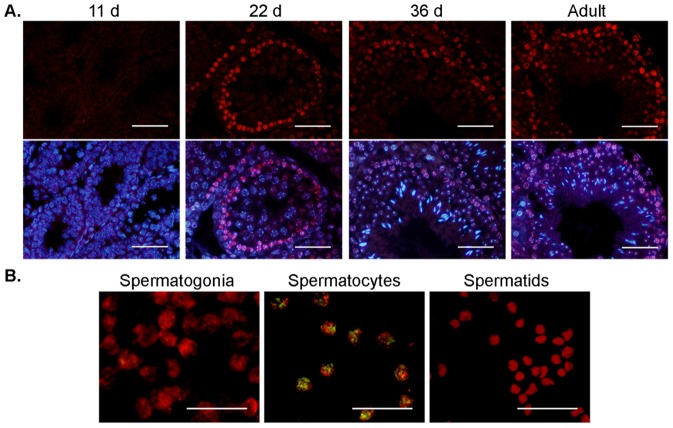
Protein expression of CYP2E1 in the male germ line.(A) Immunolocalisation of CYP2E1 (red staining) in testis sections at different developmental stages, 11 d after birth, 22 d after birth, 36 d after birth, and adult (older than 56 d). Sections were sequentially probed with anti-CYP2E1 and appropriate secondary antibody before being counter-stained with DAPI (blue staining). CYP2E1 protein expression was found in spermatocytes at 22 d after birth to adult testis, with weaker staining observed in spermatids. Diagram outlining where different male germ cell types reside in the seminiferous tubule is shown in supplementary data. (B) Immunolocalisation of CYP2E1 in isolated spermatogonia, spermatocytes and spermatids, showing CYP2E1 expression (green staining) in spermatocytes. Germ cells were probed with anti-CYP2E1 and anti-GCNA, which labels spermatogonia and spermatocytes, or anti-PKA[C], which labels spermatids (red staining). Both tissue sections and cells were probed with rabbit serum in the absence of primary antibody as a control, which did not produce a detectable signal (blank images not shown). Scale bars equal to 50 µm.